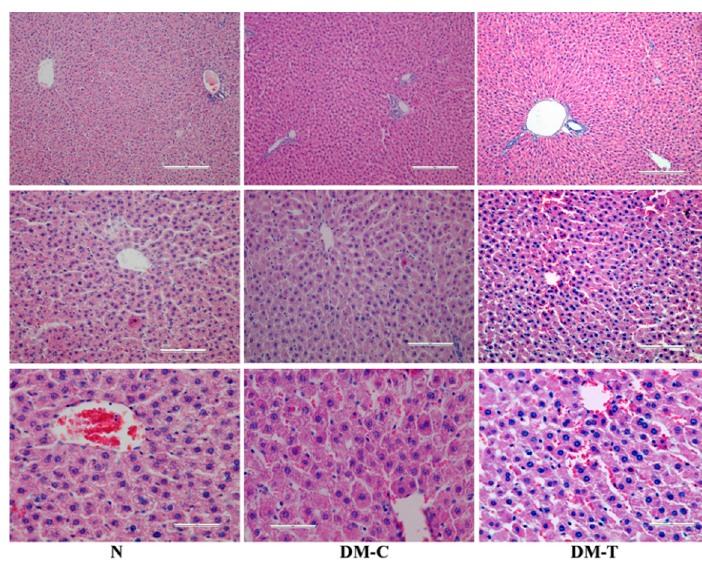
Figure 4. Histopathologic examination of liver in N, DM ‐ C, and DM ‐ T rats. The kidney morphology appears in Figure